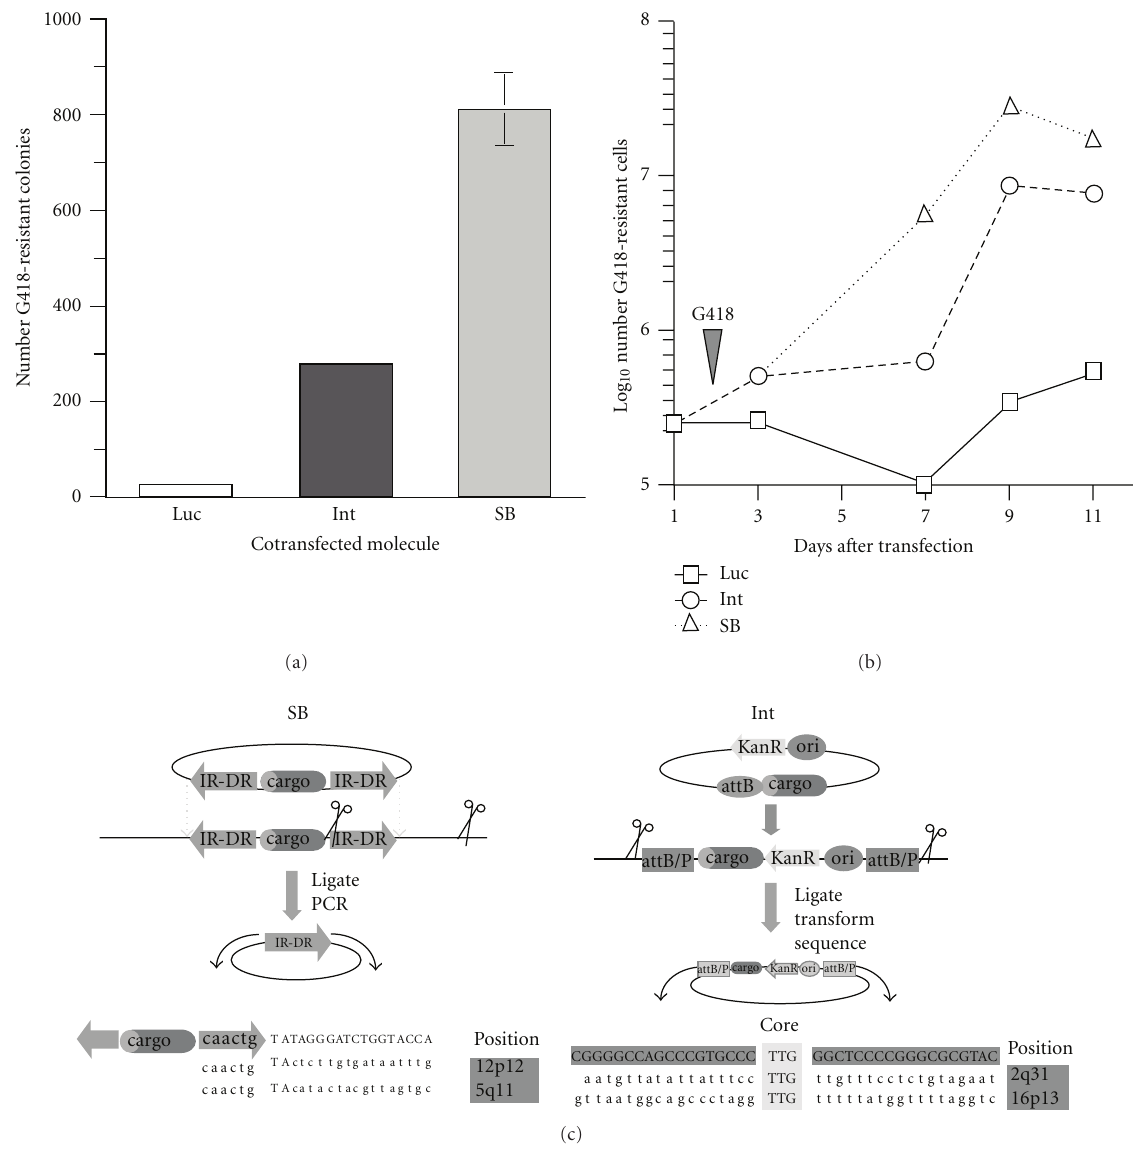
Figure 3: Non-viral integration e ffi ciency in MAPC. Nucleofected rMAPC were plated and the medium was supplemented with G418 (400 μ g/mL) one day later. (a) Colony-forming assay. After 10–12 days of growth under selective conditions, cells were fixed and stained to determine the frequency of G418-resistant colony formation. The number of G418-resistant colonies ( n = 3) for each group is shown ± S.D. (b) Cells were harvested into a suspension and viable cell counts were performed by trypan blue exclusion on the indicated days and the total number of cells in culture is reported as mean ± SE. (c) Genomic DNA isolated from the individual clones obtained with SB and Int was subjected to restriction enzyme digestion, plasmid sequence rescue, and sequencing of the recovered fragment carried out to determine the genomic site of